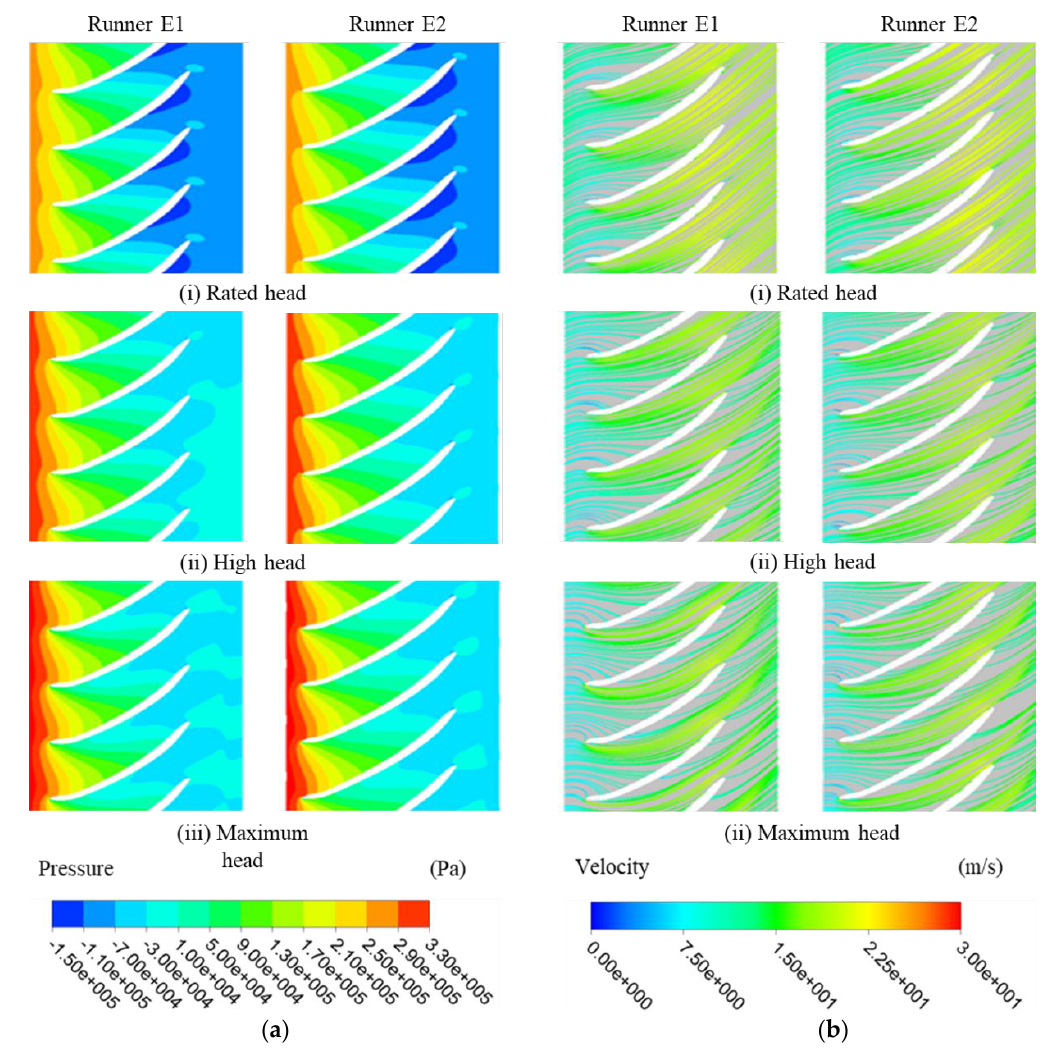
Figure 17. Flow conditions on the middle span surface of runners E1 and E2, ( a ) pressure contours, ( b ) surface streamlines.